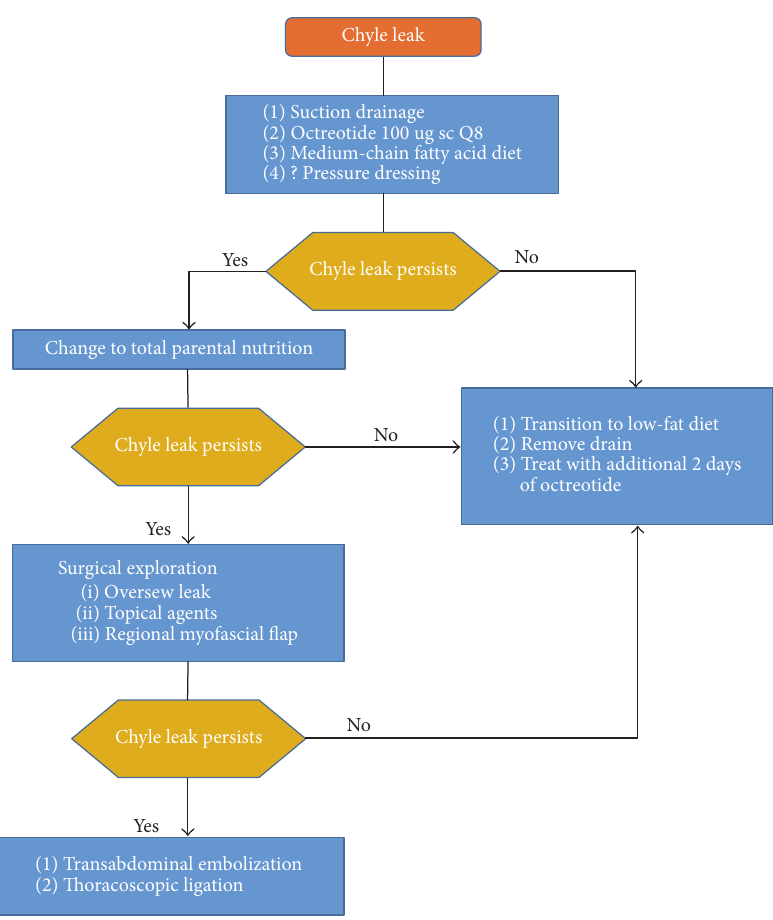
Figure 3: Proposed treatment algorithm for the postoperative chyle